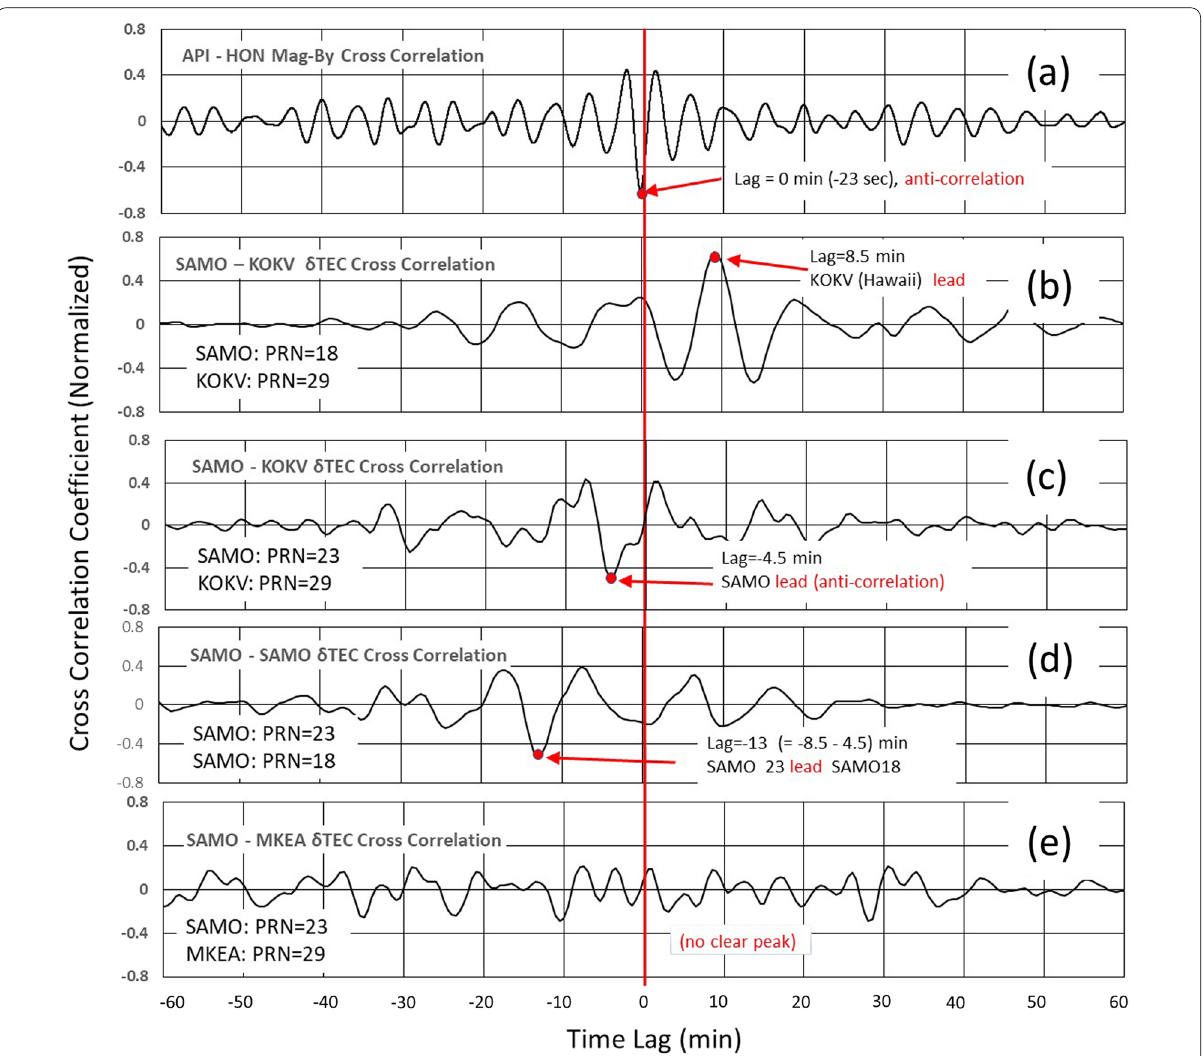
Fig. 9 A cross-correlation function of geomagnetic oscillation between the data observed at Apia and Honolulu observatories (top panel a ) and those of GPS-TEC variation between the data observed in Samoa and in Hawaii Islands (lower four panels) for a period from 04:00 to 06:00 UT. The highest correlation (absolute value) is marked by a red dot. No clear peak is seen for the case of the bottom panel e . The rapid decrease of the coefficient (absolute value) toward both sides of the point with highest coefficient in the upper four panels suggests that the time-lag is meaningful. On the other hand, the coefficients in the bottom panel do not have a clear peak and do not decrease toward both ends of time-lag